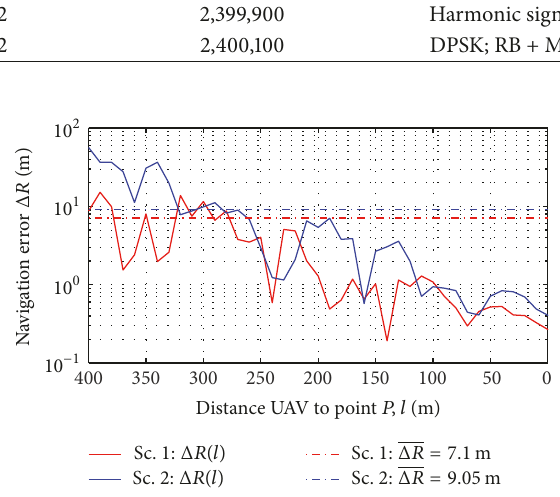
Figure 5: Navigation error for Sc. 1 and Sc. 2 and 𝑇 1 .